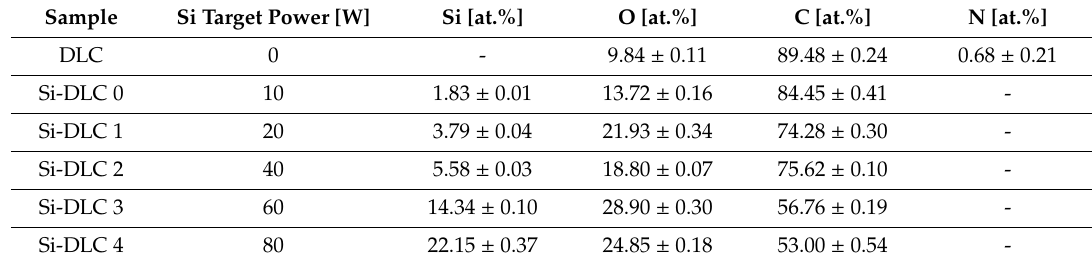
Table 1. Chemical composition of the deposited DLC and Si-DLC coatings according to the XPS analysis.